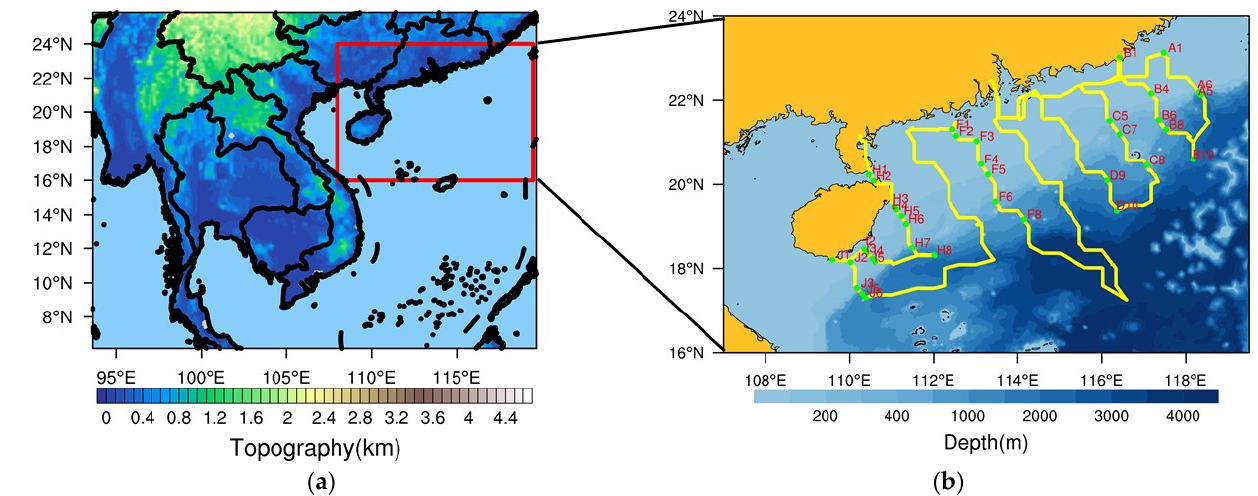
Figure 1. The ( a ) WRF model simulation domain and topography map, contours with an interval 250 m represent the terrain height, and ( b ) the routes of scientific cruise represented by yellow lines. Green dots denote the locations of useable measurements derived from micro pulse lidar and red characters A-J indicate the cruising monitoring sites.